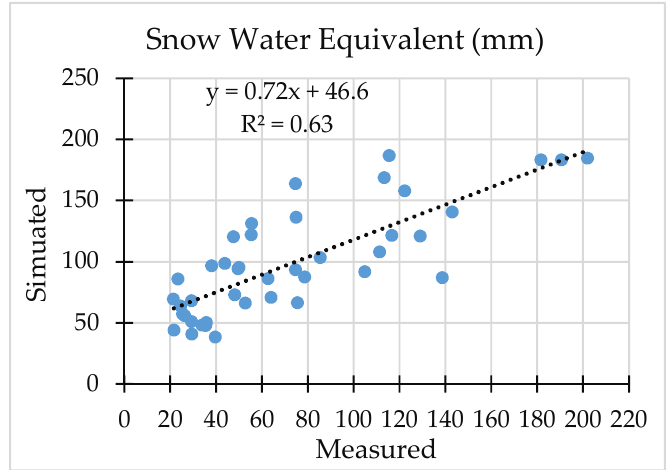
Figure 10. Comparison of monthly mean values of snow water equivalent measured at the Chimbulak meteorological station and simulated by HBV-ETH for the Kishi Almaty catchment for both calibration and validation years in 2002–2012.